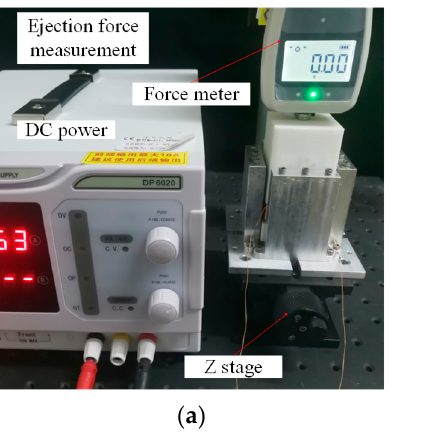
Figure 18. Measurement of electromagnetic force: ( a ) ejection force of the launcher; ( b ) attractive force and driving force of the conveying platform.